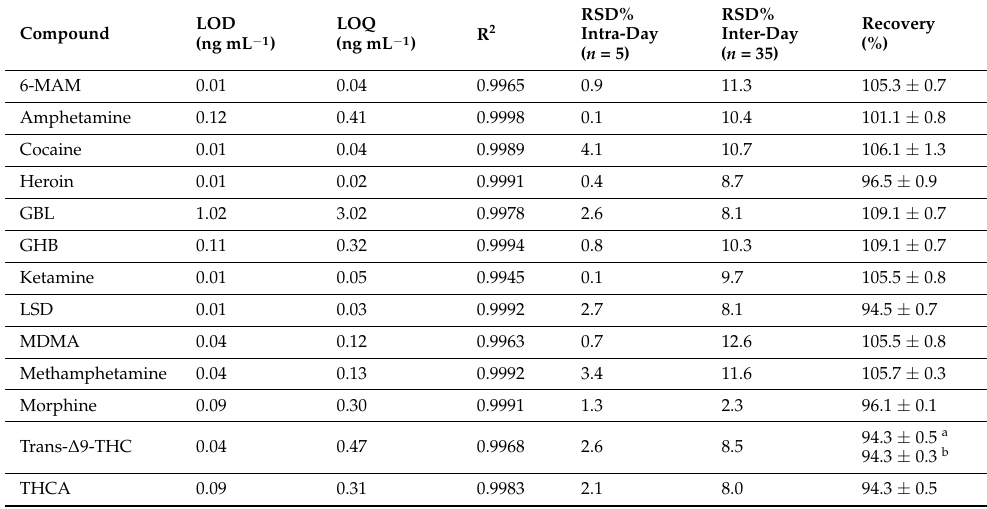
Table 1. LOD, LOQ, R 2 , and intra- and inter-day RSD (%) of concentration and average recovery for each